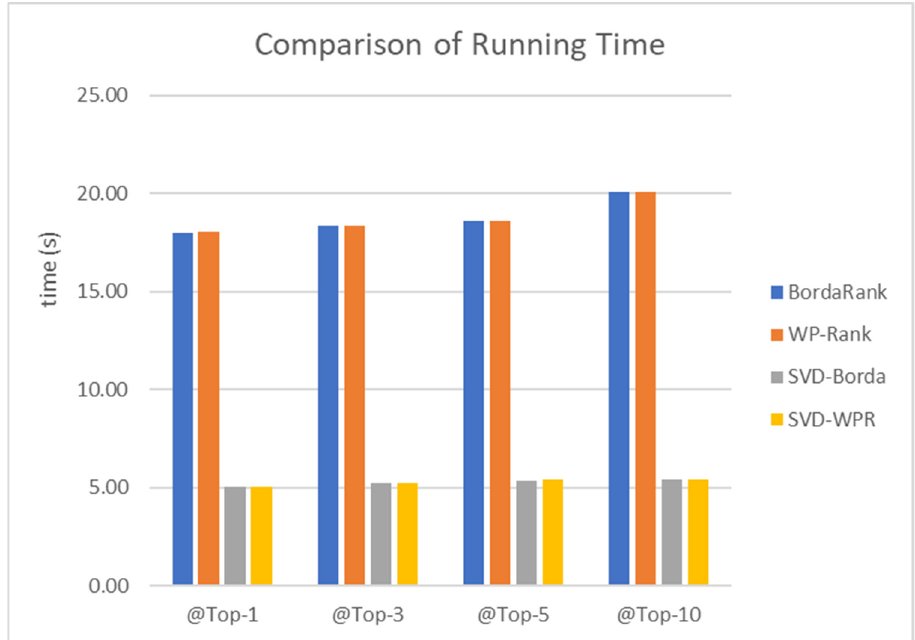
Figure 5. Running time comparison of each algorithm in the MovieLens 100K